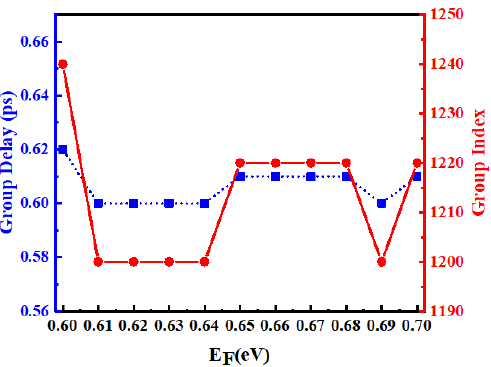
Figure 7. Variation of group delay and group index with chemical potential.